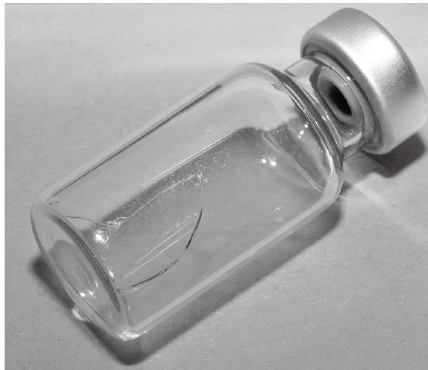
Figure 1: After a light and short contact with the fi lter cannula, fi ne continuous cracks on the glass vial were seen. Although no A fl ibercept solution had escaped, the active ingredient — possibly no longer free of contamination — was not